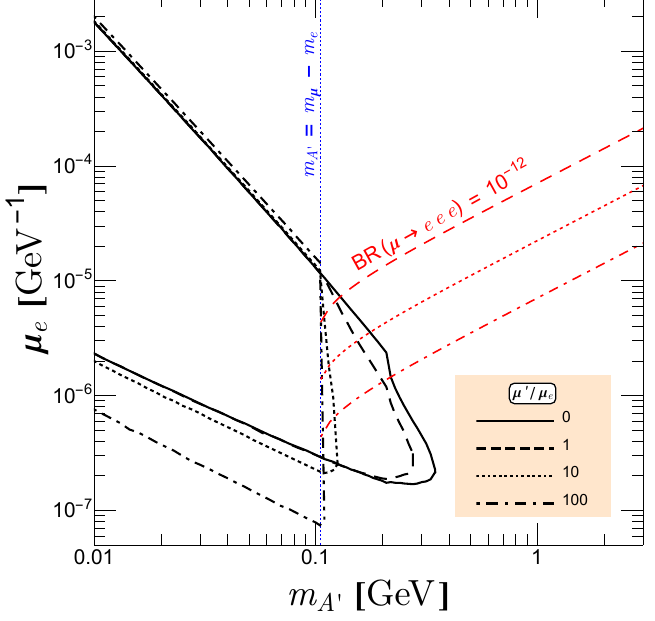
Figure 9 . The same plots as figure 6 for the dipole interaction. The dipoles are taken to µ 0 /µ e = 0 (solid), 1 (dashed), 10 (dotted), and 100